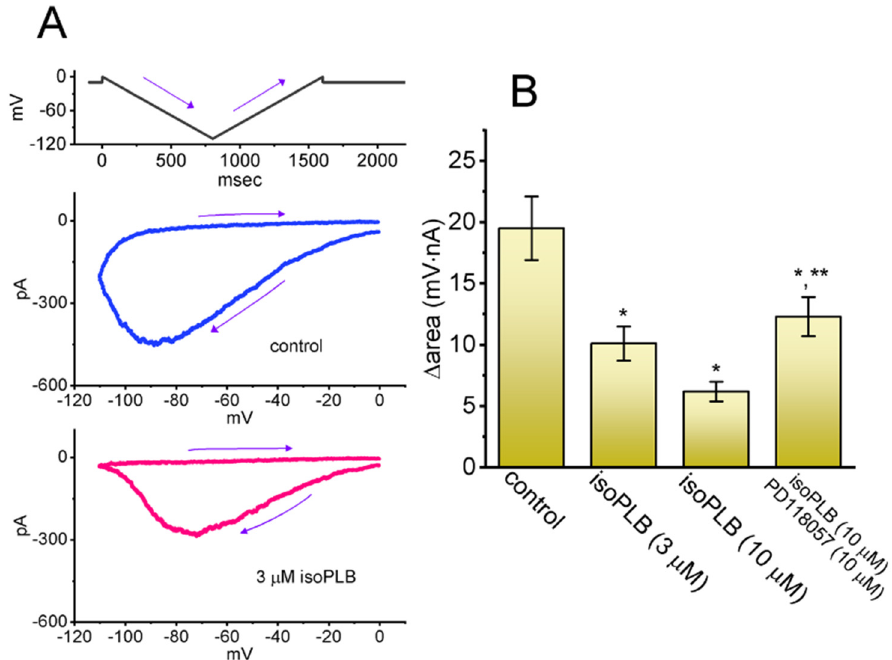
Figure 6. Effect of isoPLB on the V hys of I K(erg) evoked during the double (i.e., inverted isosceles- triangular) ramp voltage (V ramp ). These experiments were conducted in cells which were bathed in a Ca 2+ -free Tyrode’s solution containing 1 μ M TTX and 0.5 mM CdCl 2 ; we then filled the pipette with a K + -enriched solution. ( A ) Representative V hys traces (i.e., the relationship of descending or ascending I K(erg) versus membrane voltage) obtained in the control period (upper, blue color) (i.e., absence of isoPLB) and during exposure to 3 μ M isoPLB (lower, red color). The top part indicates the voltage-clamp protocol delivered. The arrow in each panel indicates the direction of I K(erg) over time during the elicitation of an inverted isosceles-triangular V ramp . ( B ) Summary bar graph showing the effectiveness of isoPLB and isoPLB plus PD118057 in altering the V hys ∆ area (i.e., area under the curve activated during the downward and upward limb of triangular V ramp ). The ramp speed in these experiments was set at ±183.3 mV/sec. Each bar indicates the mean ± SEM ( n = 8). The analysis was carried out with ANOVA-1 ( p < 0.05). * Significantly different from control ( p <